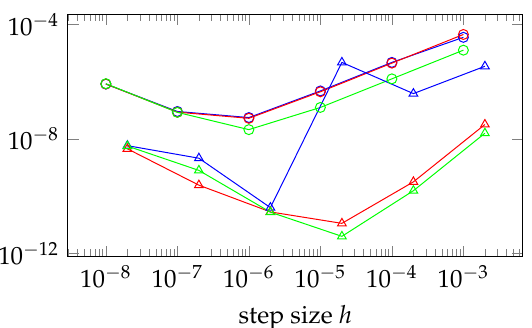
Figure 7. Accuracy of AD and DQ. Gap between difference quotients and AD-sensitivities of average concentration computed over the time interval [4 s − t p , 4 s] with regard to period length t p = 0.6 s (FDQ /CDQ , blue color), phase difference d = 0.5 (FDQ /CDQ , red color) and amplitude a = 0.5 (FDQ /CDQ , green color). Circles correspond to FDQ, triangles to CDQ. For the CDQ-sensitivity with regard to t p , the number of time steps in the temporal integration domain changes if h > 10 − 5 , which introduces another source of numerical error and gives explanation for the